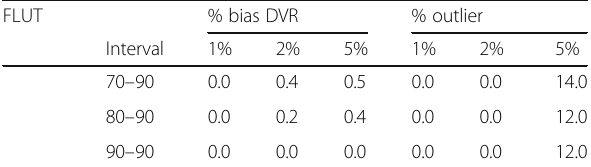
Table 3 Bias in DVR and outliers as a result of noise and the dual-time-window protocol for